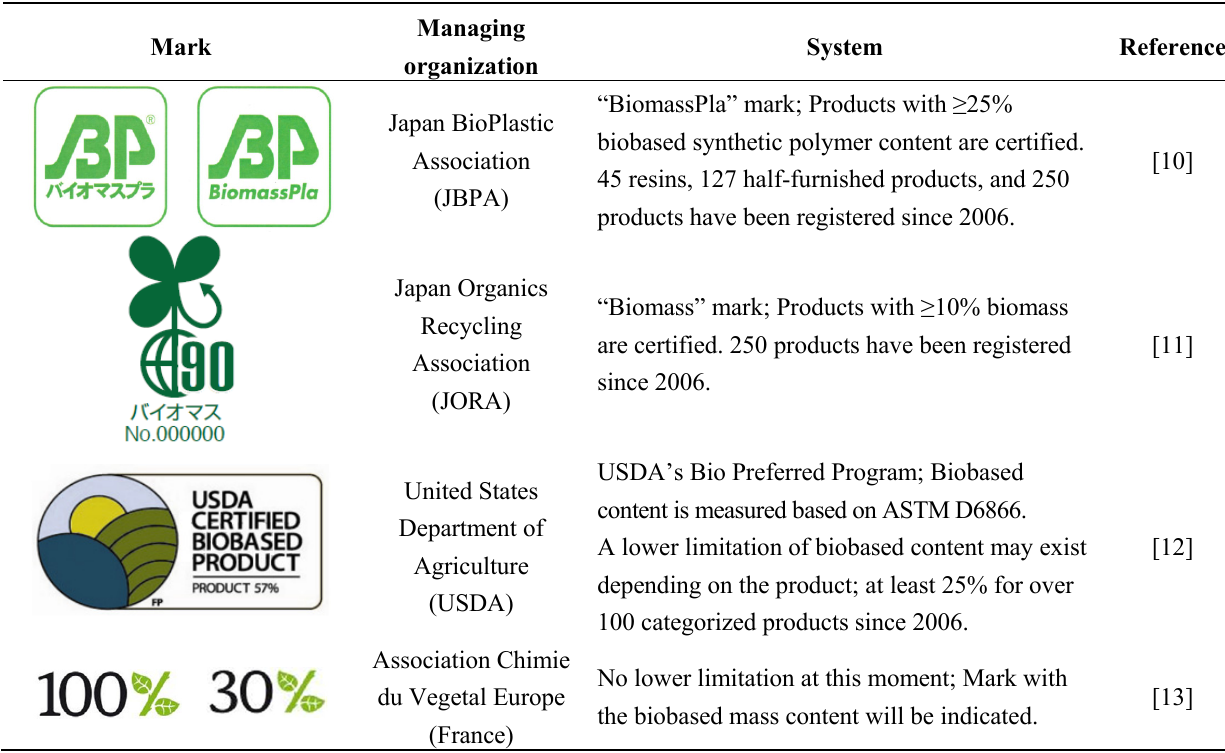
Table 3. Mark certification system using biobased